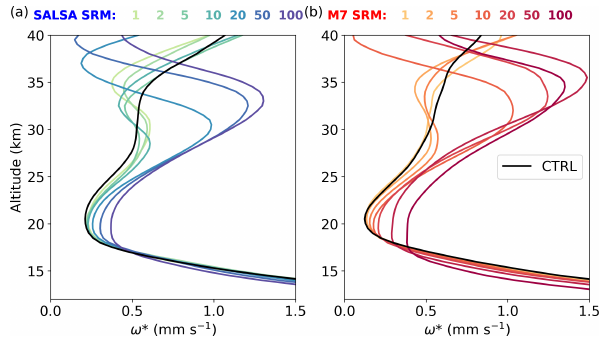
Figure 11. Residual vertical velocity in the tropics (10 ◦ N–10 ◦ S) for different injection rates in simulations with (a) SALSA and (b)